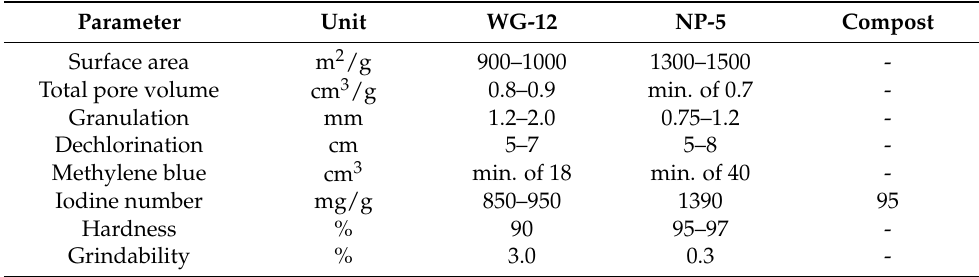
Table 1. Physical properties of activated carbon.